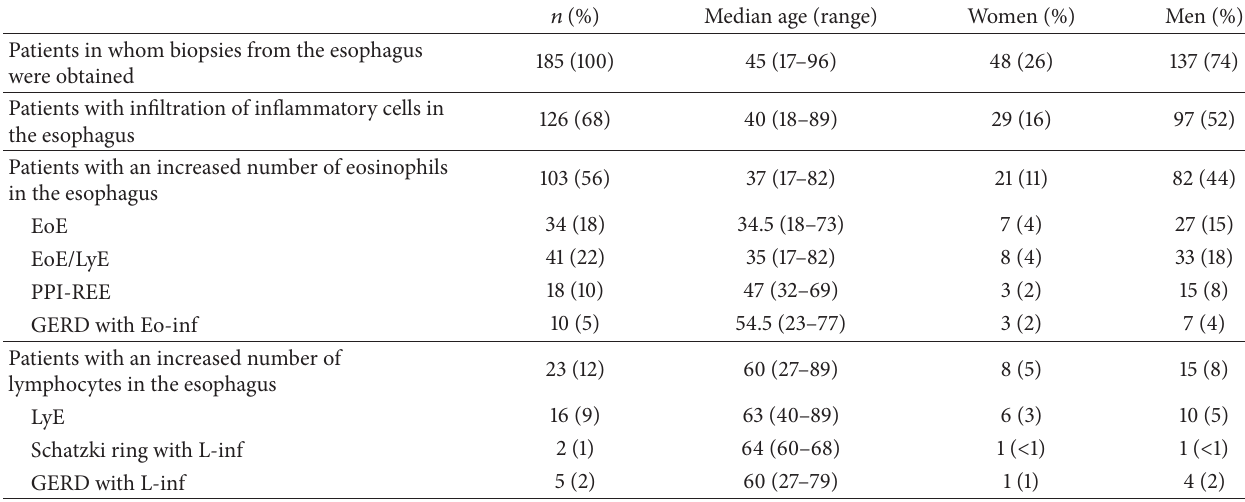
Table 3: Characteristics of 185 patients with esophageal food impaction with obtained biopsy samples from the